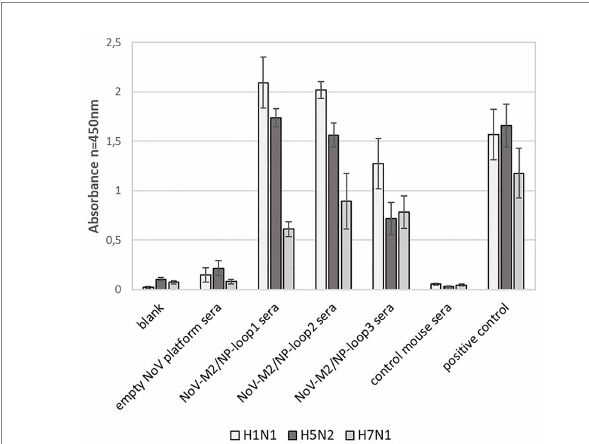
FIGURE 7 Impact of loop localization on epitope presentation via NoV-M2/NP VLPs estimated by peptide ELISA assay. ELISA plates were coated with M2 and NP peptides. For each ELISA, the mean value from three independent experiments performed is presented. The mean A450 values and standard deviations are shown on the